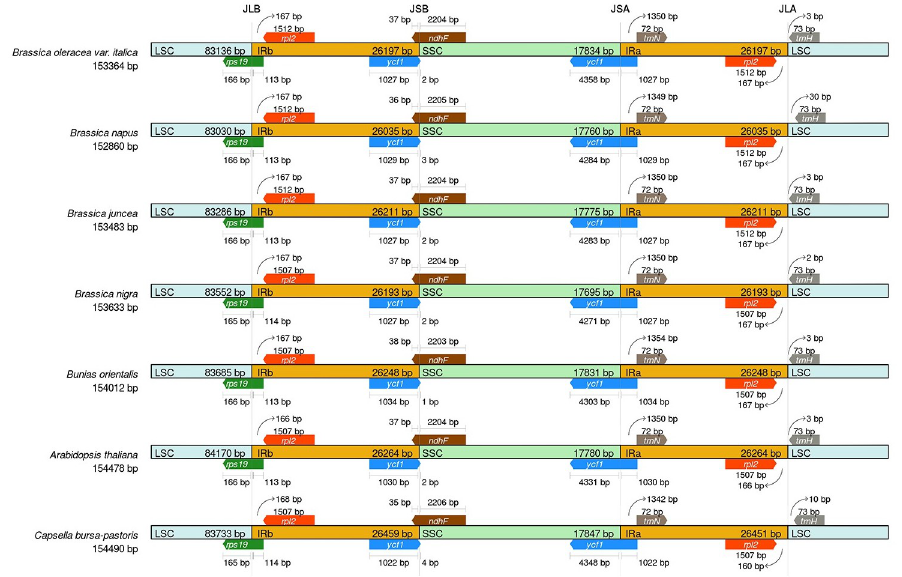
Fig 4. Comparison of boundaries between the LSC, IR, and SSC regions in chloroplast genomes of seven species. Genes are depicted by colored boxes. Boxes above or below the main line indicate adjacent border genes.